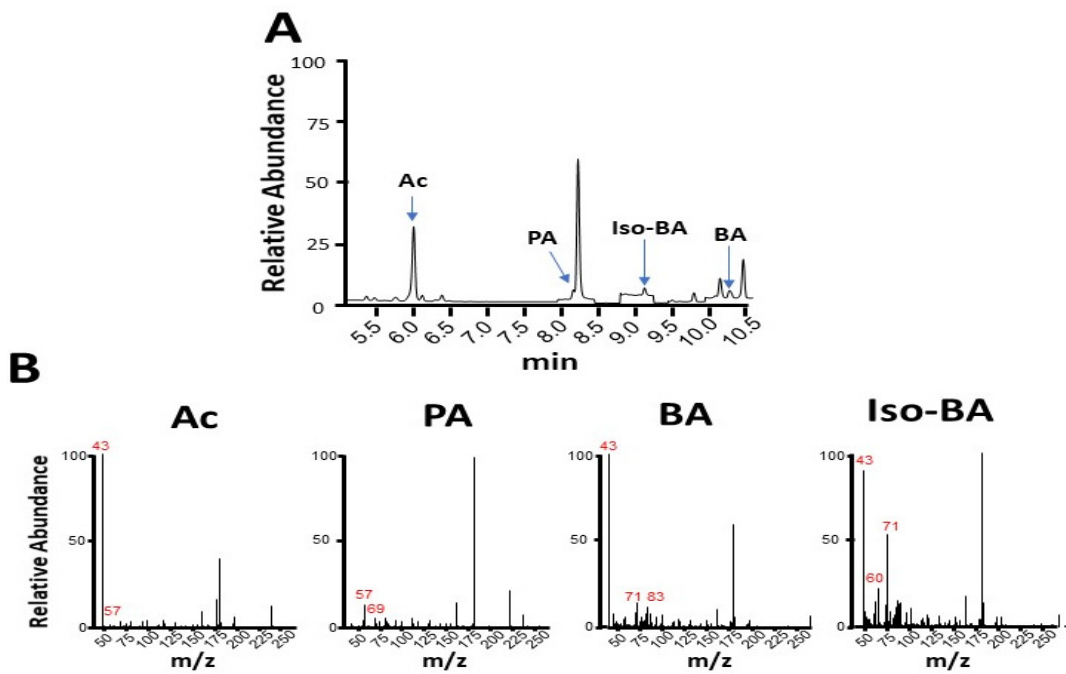
Figure 2. Production of short-chain fatty acids (SCFAs) by glucose fermentation of K. pneumoniae C strain. ( A ) Total ion chromatogram for separation of the mixture of SCFAs containing acetate (Ac), propionate (PA), isobutyrate (iso-BA), and butyrate (BA) was displayed by running the GC-MS analysis. ( B ) The mass spectra for acetate, propionate, isobutyrate, and butyrate with their corresponding molecular ions (m / z) are shown. Table 1. Enhancement of SCFA production of K. pneumoniae ( Kpn ) K1 by linolenic acid fermentation. Kpn C SCFAs / SCFAs